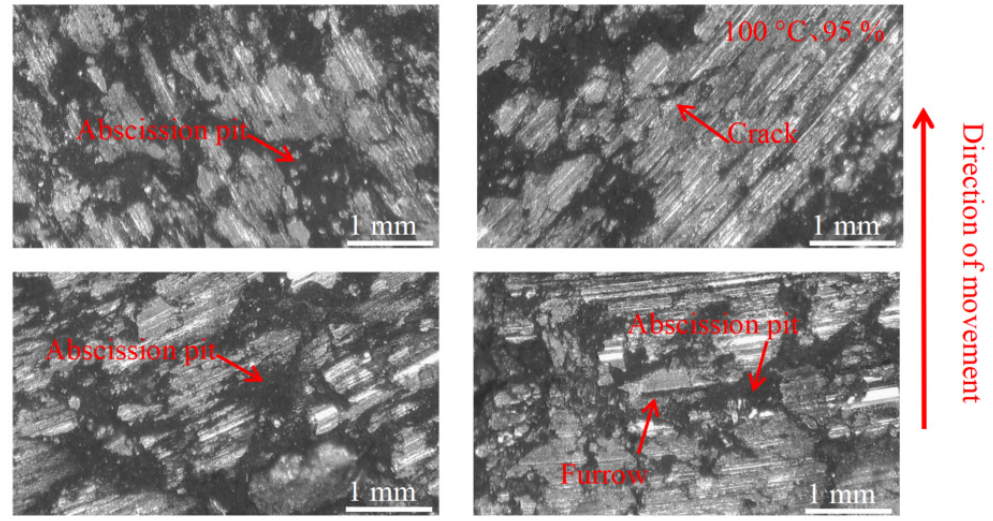
Figure 22. Surface morphology damage map of brake pad at 100 °C and 95% ambient humidity.